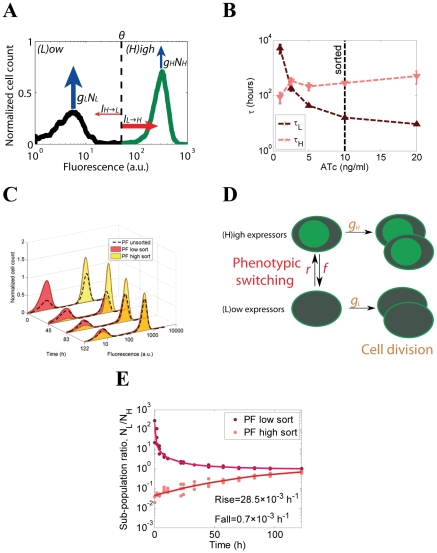
Cellular memory estimation and measurement based on the cellular current.(A) Cellular currents characterize the constant upward and downward movement of cells within stationary distributions under the influence of noise. Cells were first partitioned into 2 gene expression states, of (L)ow and (H)igh yEGFP:zeoR expression, depending on how their fluorescence compared to a preset threshold θ. The upward cellular current (IL→H) was defined as the fraction of cells leaving the L gene expression state per unit time, while the downward cellular current IH→L described movement in the opposite direction. For stationary distributions where fitness is unaffected by particular expression state, the upward and downward cellular currents must cancel each other. On the other hand, unequal high and low expressor fitness values (gL≠gH) imply unequal cellular currents (IL≠IH), even in stationary distributions. (B) Cellular memories estimated from the gene expression distributions in Fig. 2E using the cellular current model, incorporating instantaneous cellular fitness differences. For example, cellular memory of the H state is the average time it takes for a H cell to cross the preset threshold downward. (C) Histograms of cells sorted into high and low yEGFP::zeoR expression states and maintained in 10 ng/ml ATc-containing medium over several days. Cell sorting occurred at time 0 after fluorescence distributions stabilized (did not change between subsequent measurements). Experimental fluorescence histograms of high-sorted and low-sorted cells relaxing back to the stationary distribution are shown for 122 hours. (D) Schematic of the two state population-dynamics model used to estimate switching rates. (E) Low to high expressor subpopulation ratio (R = NL/NH) after sorting PF cells into predominantly high and low expressor subpopulations. Experimental time course data (dots) of low-sorted and high-sorted subpopulations and the corresponding fits (lines) based on the two-state population dynamics model illustrate their relaxation back to their original bimodal distributions. The “rising” and “falling” rates were estimated from both low-sorted and high-sorted cell populations, revealing a higher gene expression memory for PF high expressors as compared to low expressors.